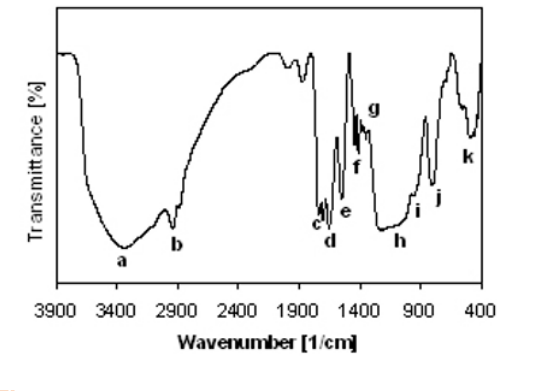
Figure 1. FTIR spectrum of the support studied where peaks were assigned: a : O-H stretching; b : C-H stretching; c : C=O bonds of an ester; d : angular vibrations of the water molecule; e : C=O bonds of an amide; f : N-N frequencies; g : azo-mode; h : siloxane vibrations; i : silanol deformation; j : Si-O-Si stretching; k : Si-O-Si